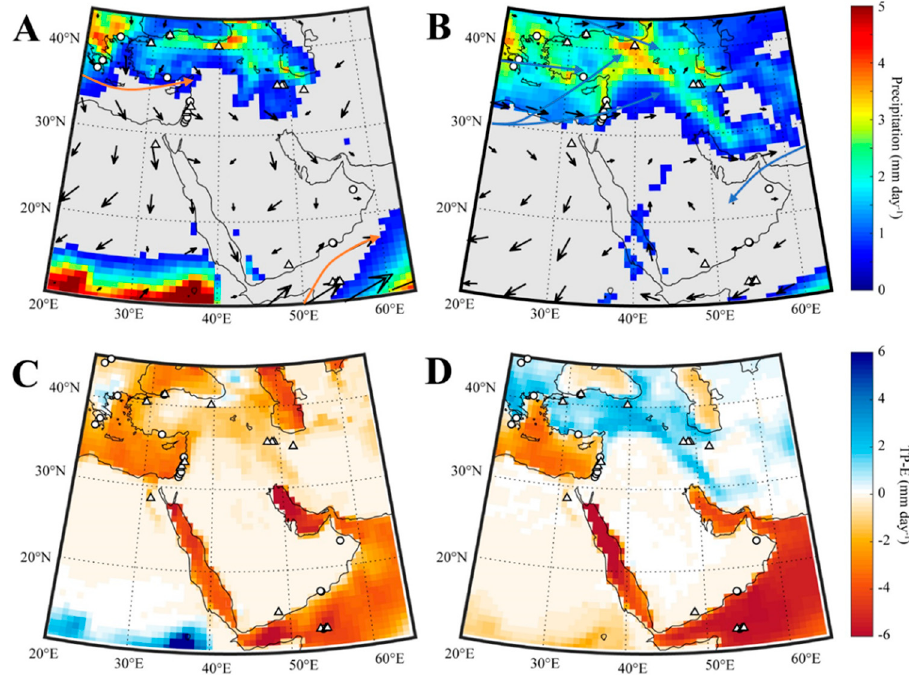
Figure 2. Maps showing seasonal precipitation amounts and water balance in the study region. Panel ( A ) and ( B ) illustrate seasonal precipitation amounts from June to September (JJAS) and from December to March (DJFM), respectively. Grey areas indicate regions where the daily precipitation amount is smaller than 0.5 mm. These panels also show the seasonal 850 hPa wind fields in the EM, AP and FC. Common storm trajectories are superimposed on the image and shown by the black arrows. Panels ( C ) and ( D ) show the seasonal water-balance: Total Precipitation (TP) minus Evaporation (E), for the periods JJAS (C) and DJFM (D), to best estimate the potential recharge (or “e ff ective infiltration”). All data was retrieved from the ERA-Interim reanalysis dataset (1979 to 2015 CE) [96]. Following Figure 1, circles show the locations of speleothem records that are included in SISAL_v1, while triangles mark identified sites not included in